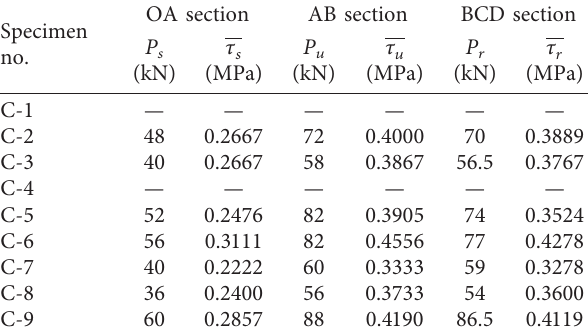
Figure 8: Load-slip curves. Table 2: Load characteristics and average bond strength